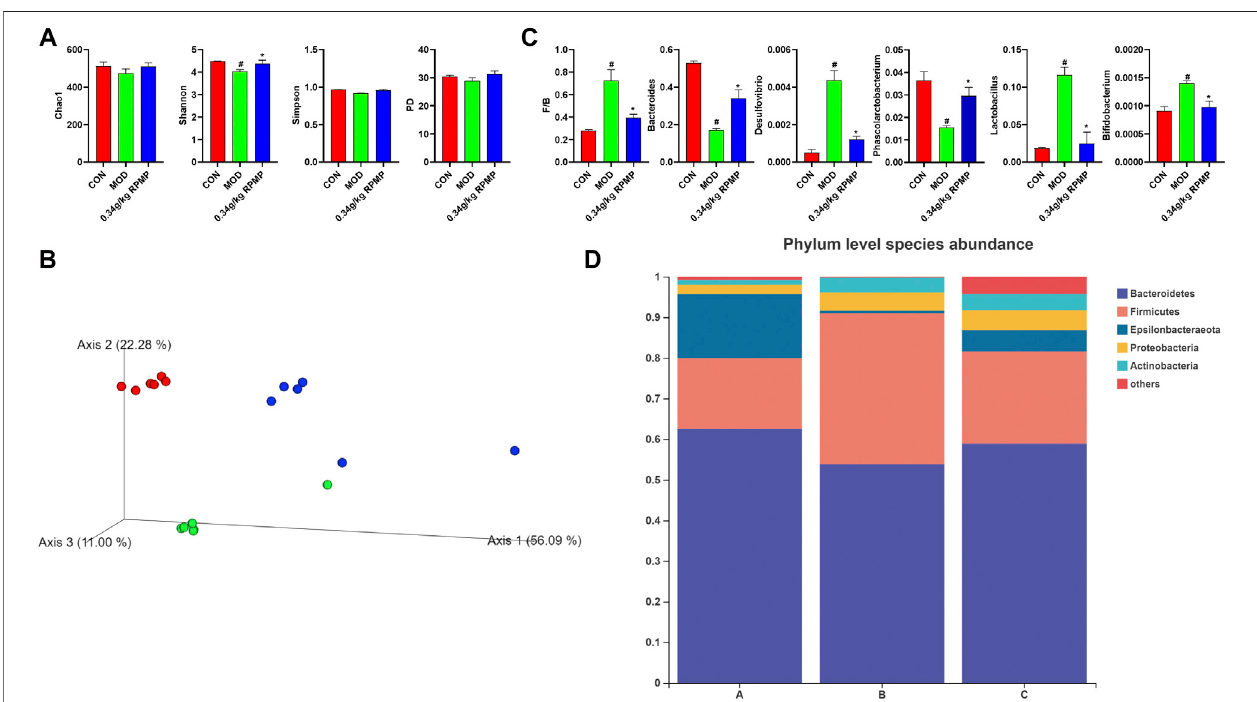
FIGURE 6 | Effect of RPMP on the IM composition of mice. (A) α -Diversity Index. (B) Principal Co-ordinates Analysis (PCoA). (C) Species Abundance. (D) Distributionofspeciesatthephylumlevel.Thedatawerepresentedasthemeans ± SEM,#p < 0.05,comparedwiththeCONgroup;*p < 0.05,comparedwiththeMOD group. Group A: CON group. Group B: MOD group. Group C: 0.34 g/kg RPMP ethanol extract group. (n (cid:2)